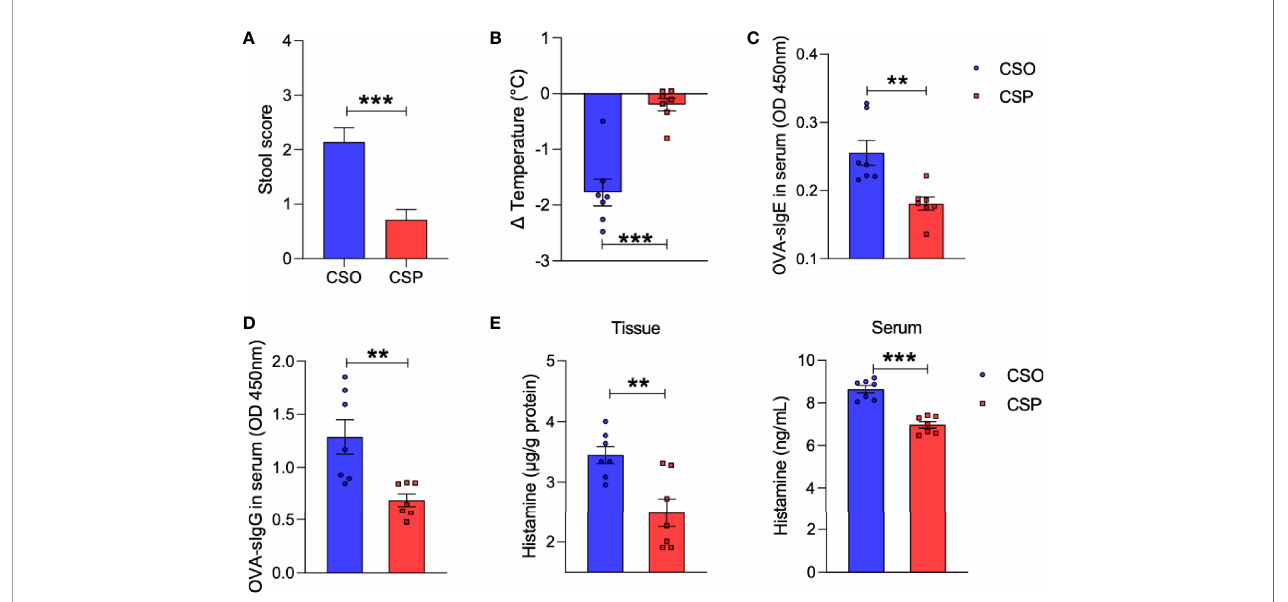
FIGURE 6 | Probiotics reduce allergic response to OVA. (A) The severity of allergic diarrhea was judged by stool score. (B) Changes in rectal temperature at 25 min after sensitization. (C, D) OD 450 was used to indicate the relative levels of OVA-speci fi c IgE (C) and IgG (D) in serum. (E) Histamine level in the ileum or serum measured by ELISA. For (A), bars represent meanand SEM. n = 7. For (B – E) , circles and squares represent individual rats, and bars represent mean± SEM. n = 7. Statistical signi fi cance was determined by two-sided Student ’ s t-test or one way ANOVA, ** P < 0.01, *** P < 0.001. CSO, the cesarean section offspring; CSP, cesarean section with probiotic